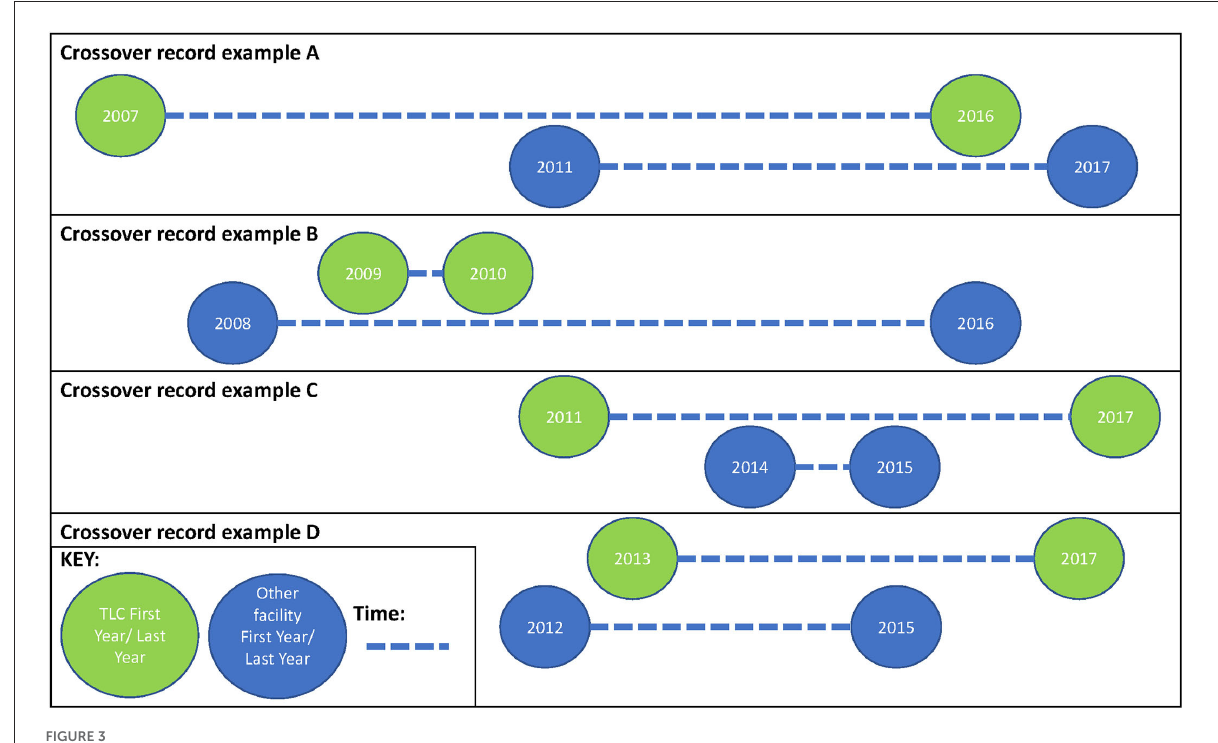
FIGURE3 Illustrative scenarios of multiple clinic switches